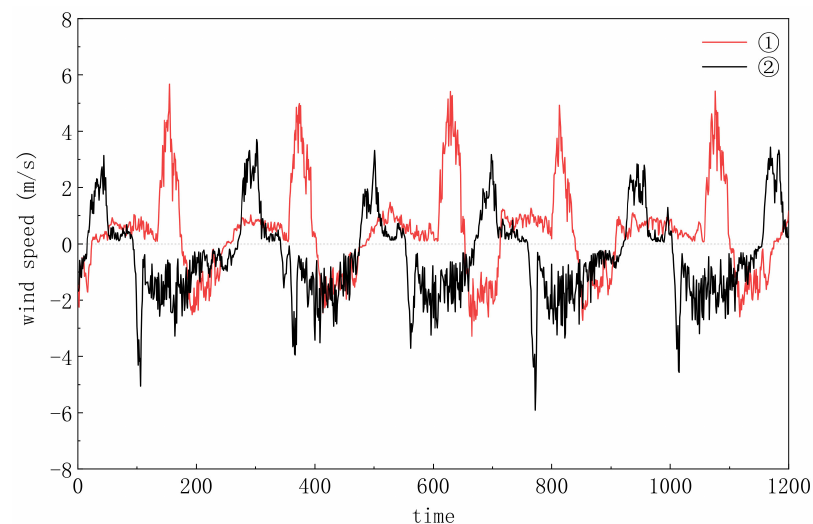
Figure 7. Wind speed variations at the inner openings of station air shafts 1 (cid:13) and 2 (cid:13) .